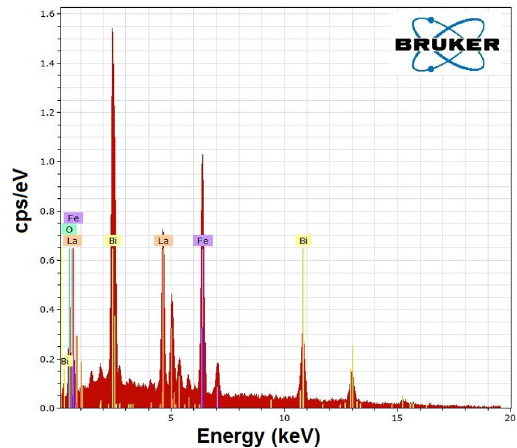
O double perovskite. 2 6